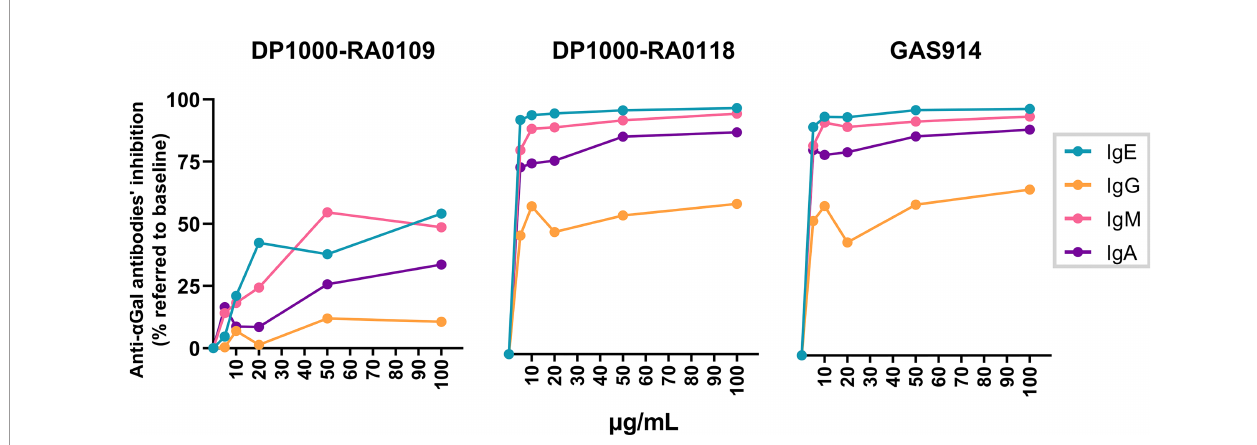
FIGURE 5 | In fl uence of a Gal load on anti- a Gal antibodies inhibition. Serum samples from a Gal-sensitized patients (n=13) were incubated with DP1000-RA0109, DP1000-RA0118 or GAS914 (positive control of inhibition) at growing concentrations (5-10-20-50-100 µg/mL). PBS-treated serum was similarly incubated as a baseline condition. After incubation, samples were conveniently diluted to determine by ELISA the unbound fraction of the different anti- a Gal isotypes (1:100 for IgM and IgG, 1:25 for IgA, and 1:10 for IgE). The inhibition rate for each glycopolymer (expressed as a percentage of anti- a Gal inhibition) was calculated according to the quantity of anti- a Gal antibodies determined in baseline (PBS) and treated (glycopolymer) conditions for each serum. IgE green line, IgG orange line, IgM pink line, and IgA purple line.